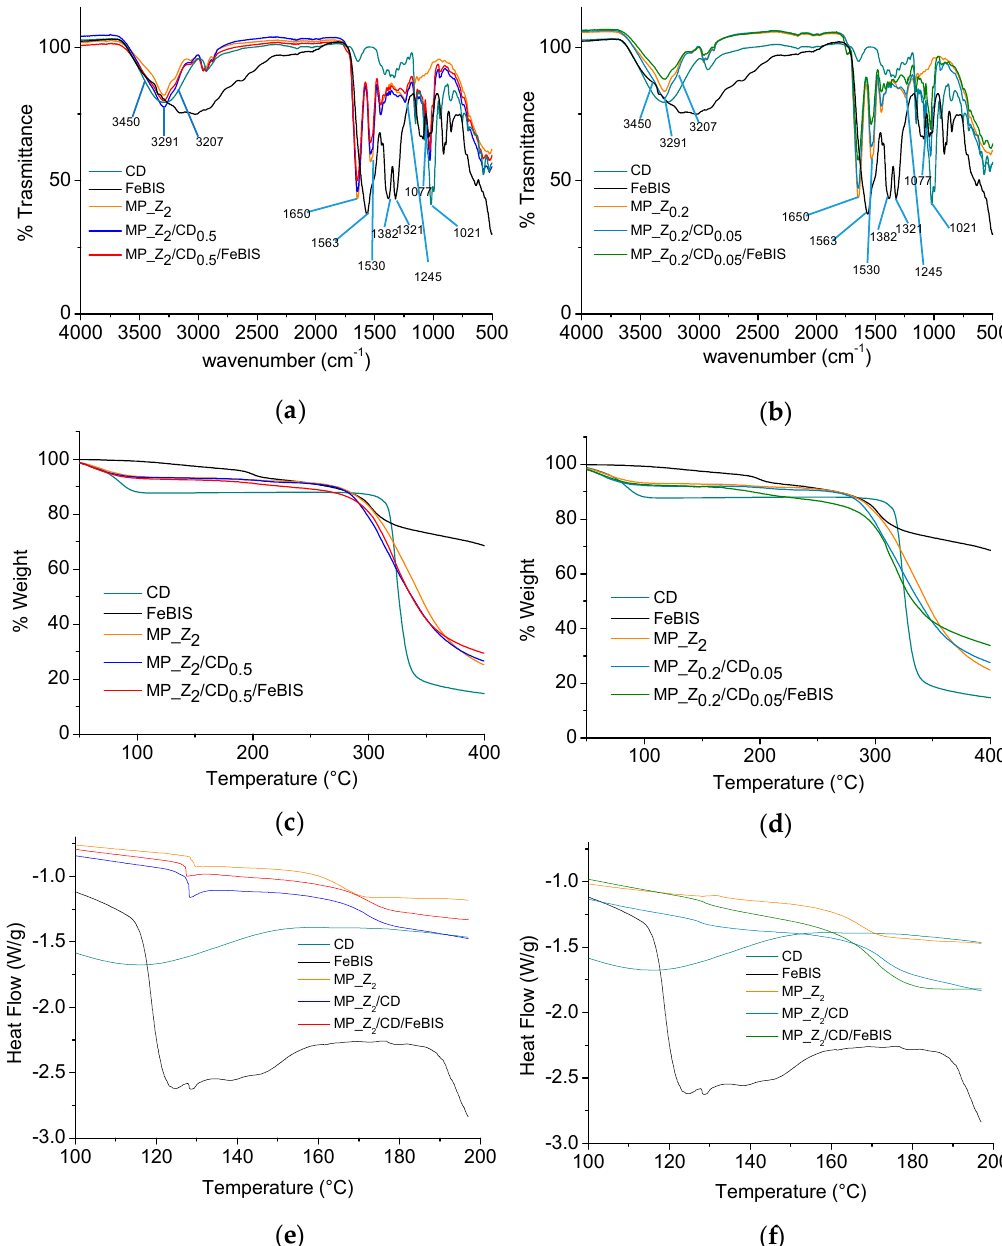
Figure 5. Fourier transform infrared (FTIR) spectra ( a , b ), thermogravimetric analysis (TGA) thermograms ( c , d ), and differential scanning calorimetry (DSC) profiles (second run) ( e , f ) for micropowders prepared at FeBIS theoretical loading of 2% ( a , c , e ) and 8% w / w ( b , d , f ) with corresponding unloaded micropowders, β CD and FeBIS (raw materials).